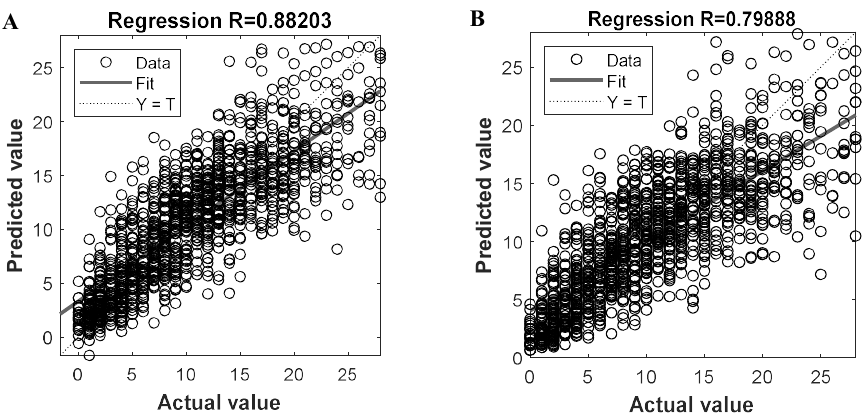
Figure 3. Prediction performance of the proposed models. ( A ) Regression coefficient R for the ANN-based PMORN; ( B ) regression coefficient R for the SVR-based PMORN. The horizontal and vertical axes, respectively, represent the actual value and the predicted value, which are denoted by the symbols Y and T, respectively.